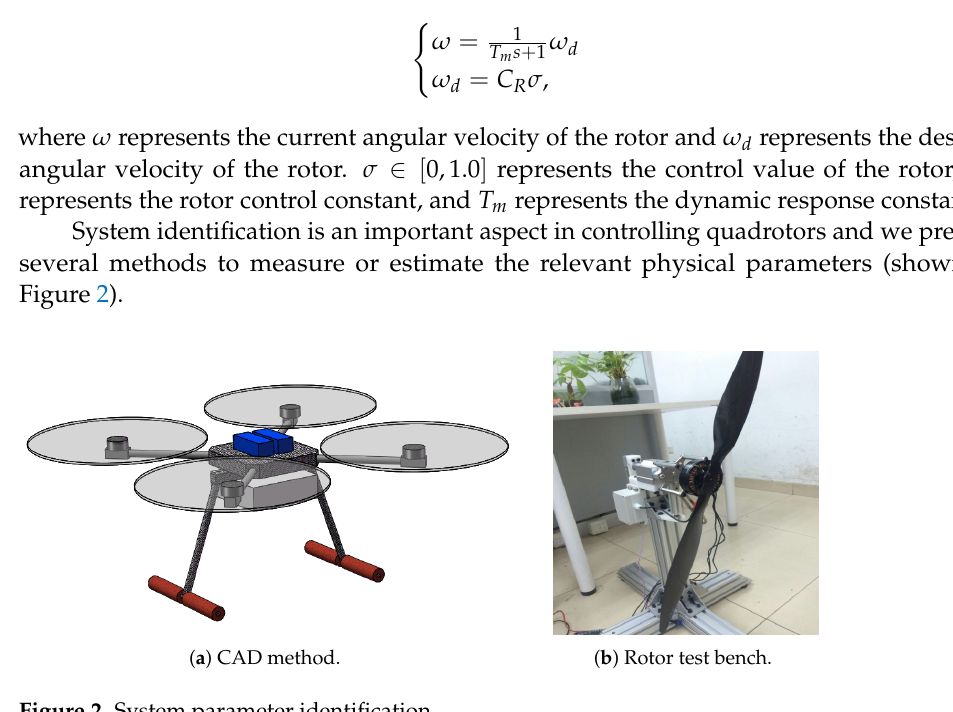
Figure 2. System parameter